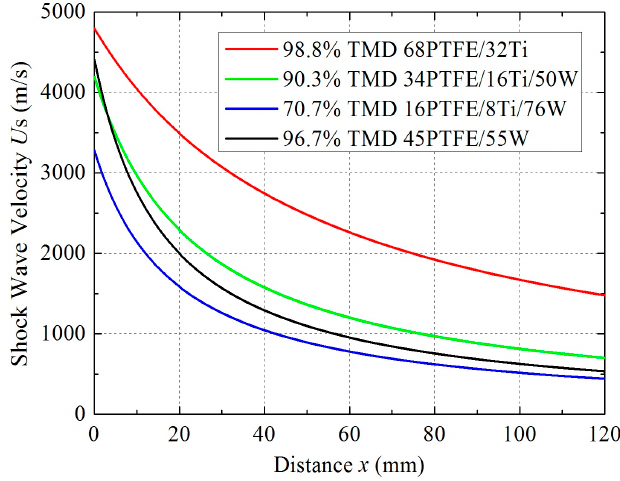
Figure 11. Velocity-distance curves for shock wave propagation.